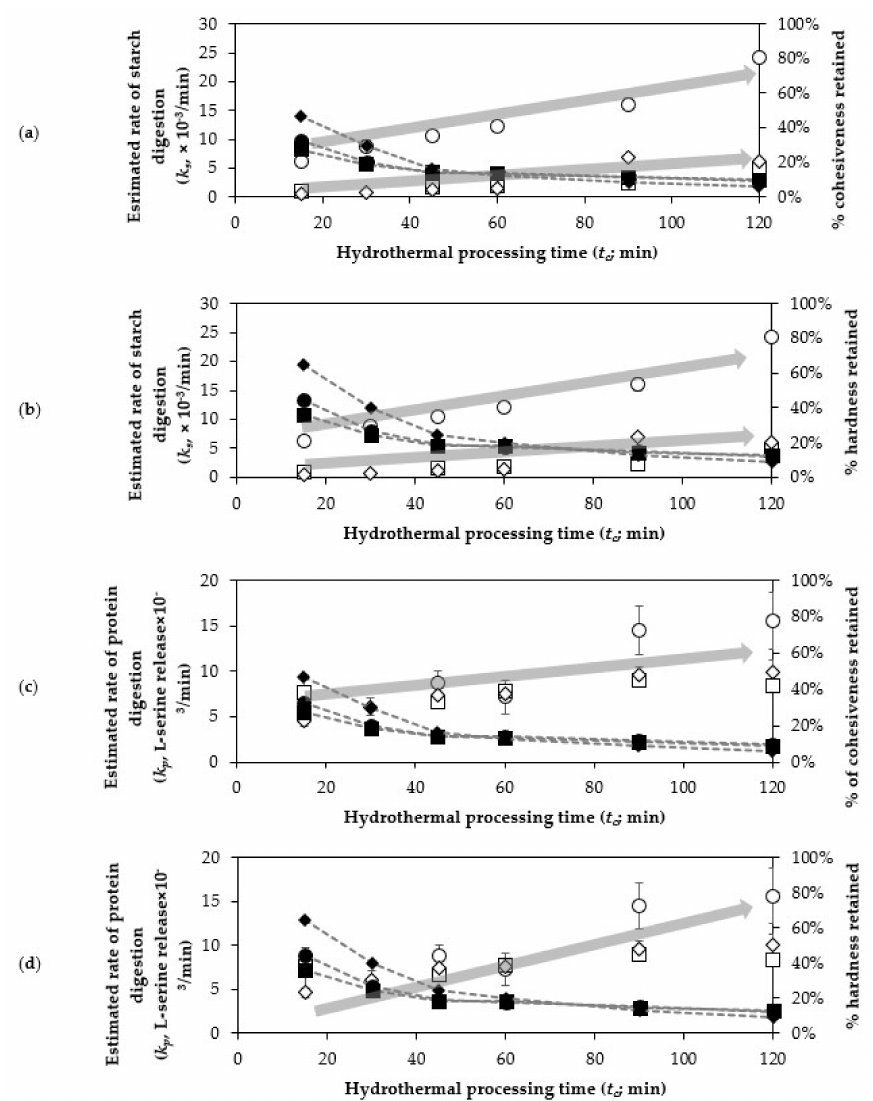
Figure 4. Relationship between the legume texture and the predicted digestion rate at the 4 h-long in vitro small intestinal phase of chickpeas, cowpeas and kidney beans as a function of hydrothermal processing time. From the top: ( a ) cohesiveness versus k s ( b ) hardness versus k s ( c ) cohesiveness versus k p ( d ) hardness versus k p . Circles represent the cowpeas; squares represent the chickpeas; and diamonds represent the kidney beans. Unfilled symbols represent the rates of digestion and filled symbols represent the texture values. Vertical error bars represent the approximate standard error of the estimated kinetic